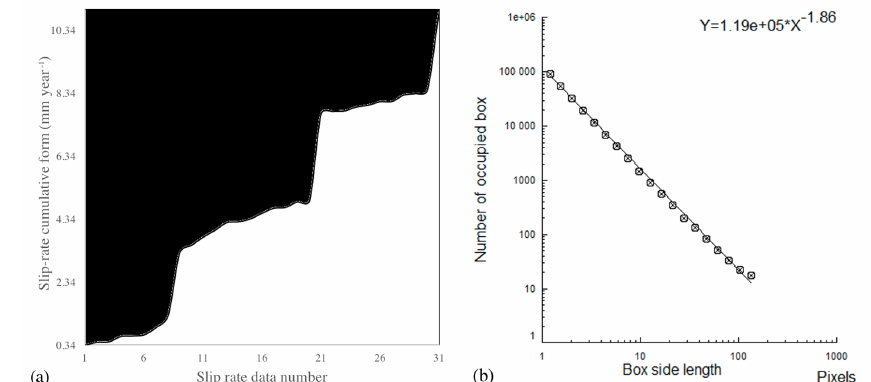
Figure 4. (a) Devil’s staircase fractal for the cumulative slip-rate (mmyr − 1 ) distribution of active faults from the east to west in the PAFS (see Table 1). (b) Log–log plot of number of boxes ( N(e) ) vs. box side length ( e ). The slope of the straight line is equal to the capacity dimension or box-dimension. The resulting D b = 1 . 86 is related to a lower concentration of low slip rates in the PAFS, suggesting that larger faults accommodate the strain more